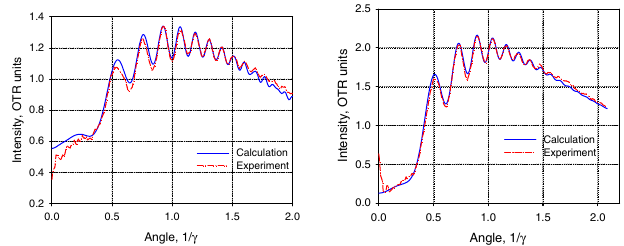
FIG. 16. (Color) Sector averaged line scans of ODTRI (left) and OTRI (right) from Fig. 15.